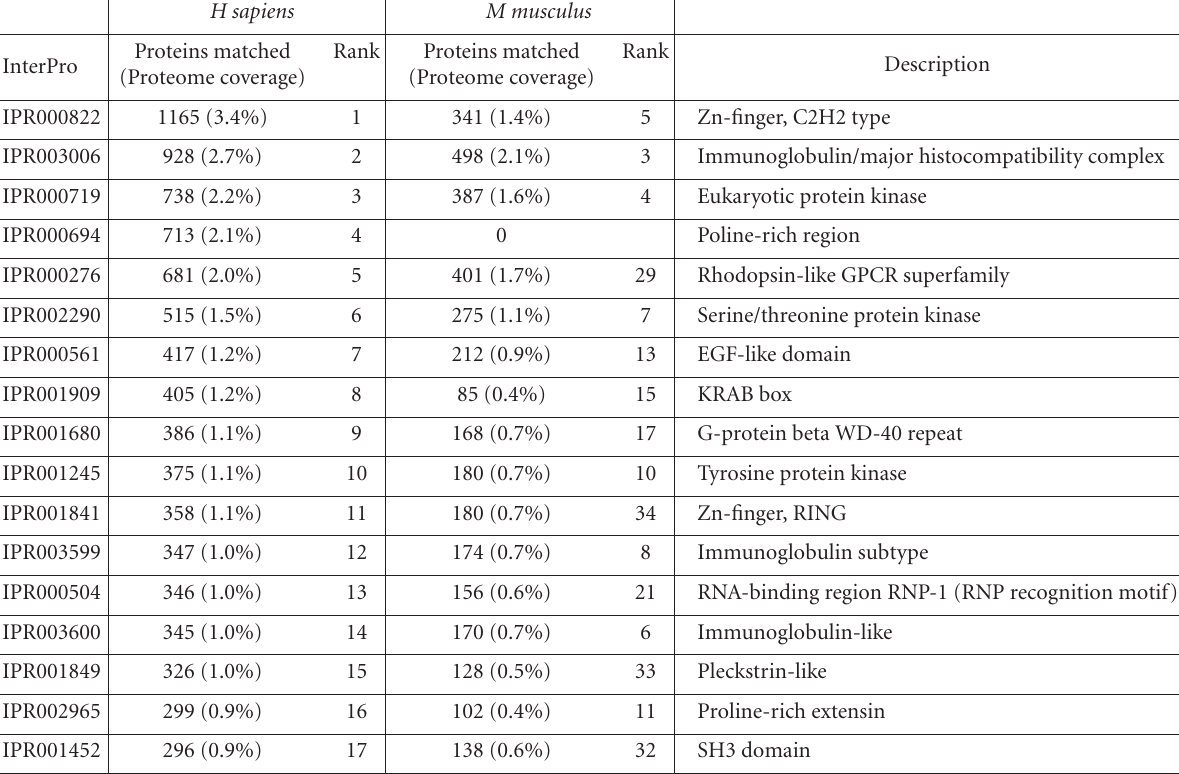
Table 1. InterPro comparative analysis of Homo sapiens and Mus musculus proteomes—the first 17 of the top 30 hits are shown. H sapiens M